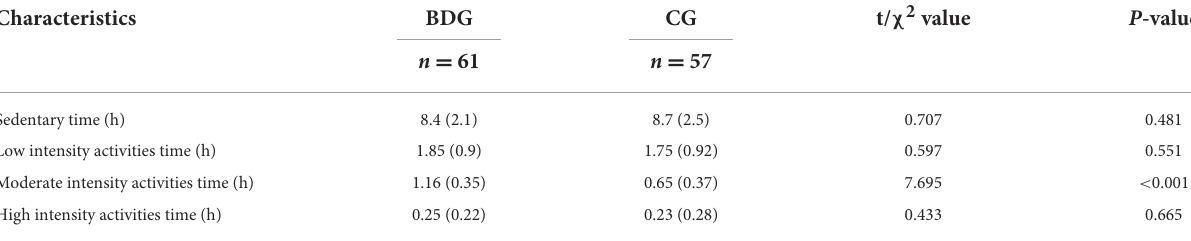
TABLE 2 The comparison of average activities time between two groups during the 12-week intervention period (hours). Characteristics